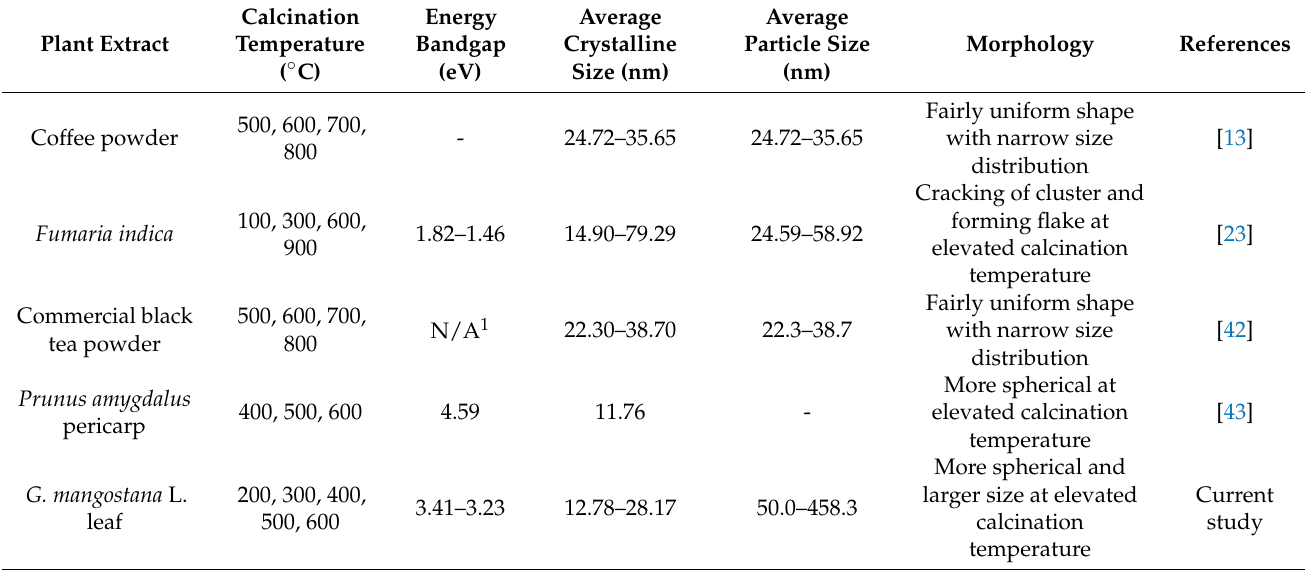
Table 4. Comparison of plant-mediated CuO NPs at different calcination temperatures with other